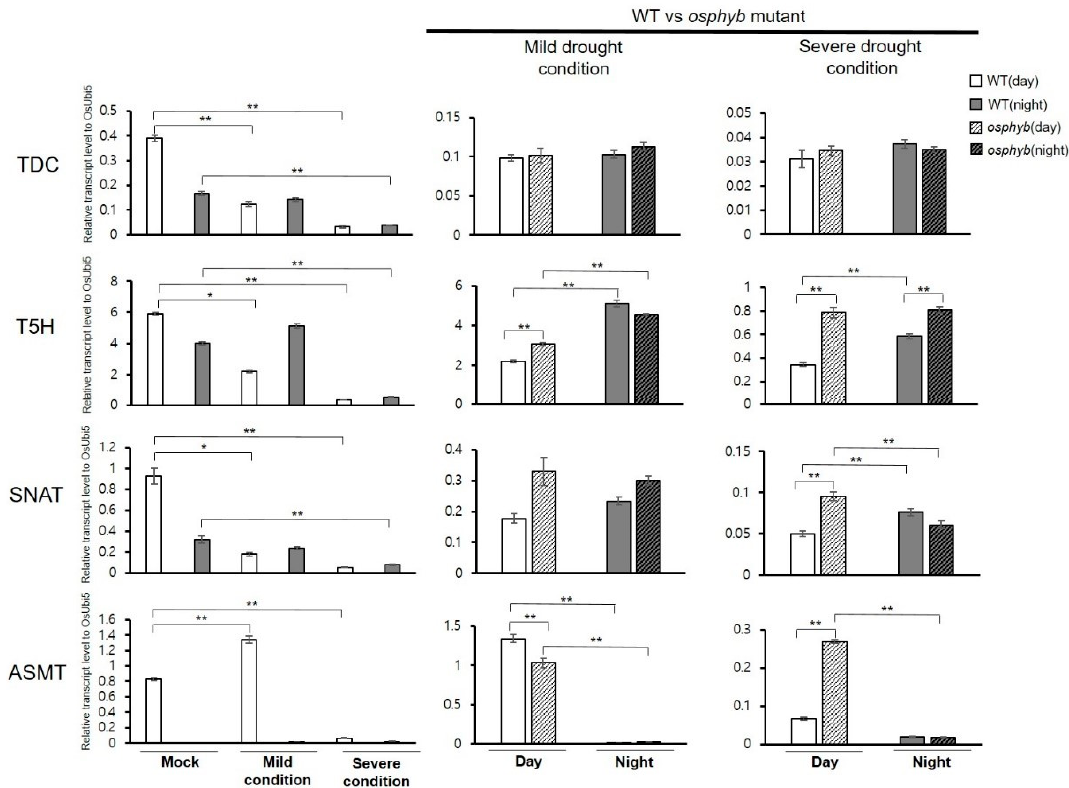
Figure 5. Expression profiles of four melatonin biosynthetic genes in response to drought stress coupled with a light–dark cycle in wild-type rice and the osphyb mutant. OsUbi5 was used as the internal control. osphyb , knockout mutant of OsPhyB ; WT—wild-type. ** p < 0.01; * 0.01 < p < 0.05.